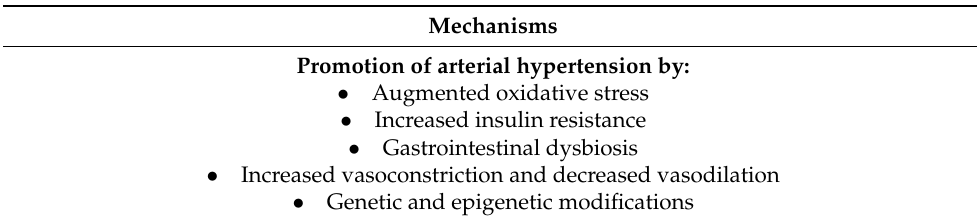
Table 3. Promotion of arterial hypertension by proposed pathogenetic mechanisms of H. pylori and MetS-related